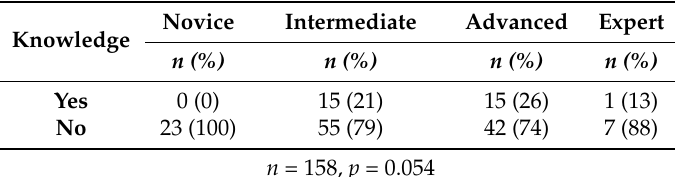
Table 7. Detection accuracy by knowledge level (dns attack).